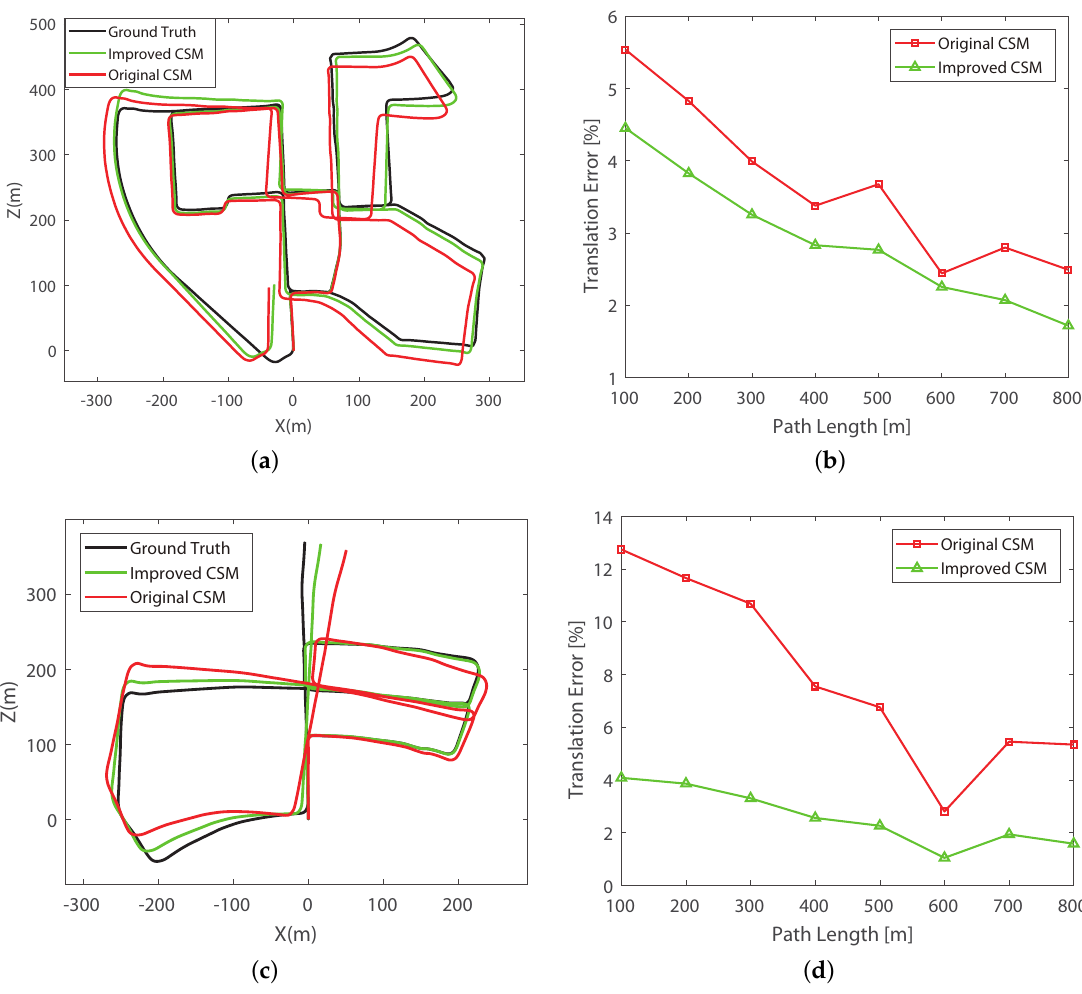
Figure 9. Results of the odometry estimation with only the front-end. ( a ) Trajectories of the 0th sequence. ( b ) Translation errors of the 0th sequence. ( c ) Trajectories of the 5th sequence. ( d ) Translation errors of the 5th sequence.